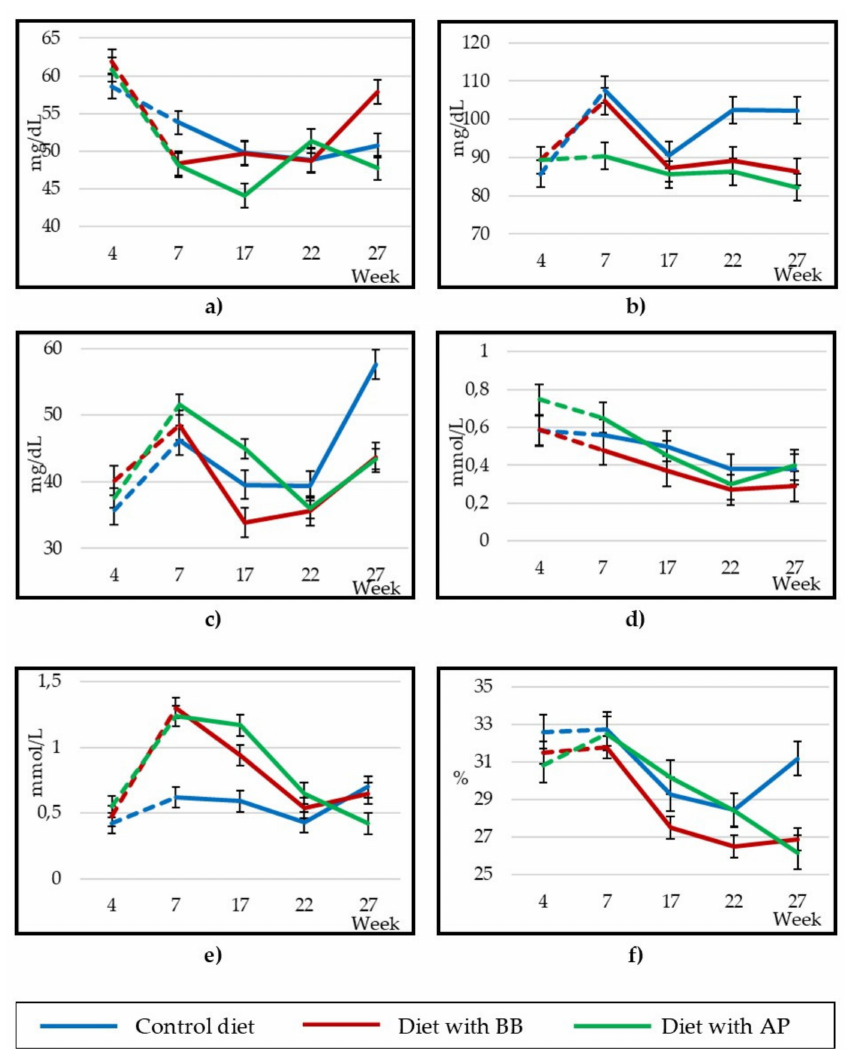
Figure 4. Changes in plasmatic metabolites (24 goats per group) throughout the experiment: glucose ( a ), cholesterol ( b ), urea ( c ), BHB ( d ), NEFA ( e ) and haematocrit ( f